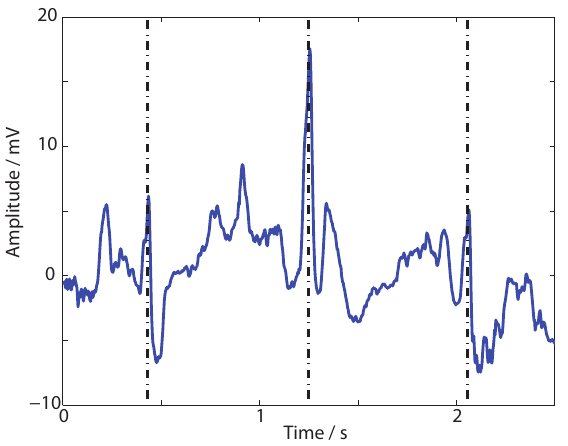
Figure 5. Input noise corrupted ECG signal from Physionet used for testing the ADWT. Black vertical lines indicate heart